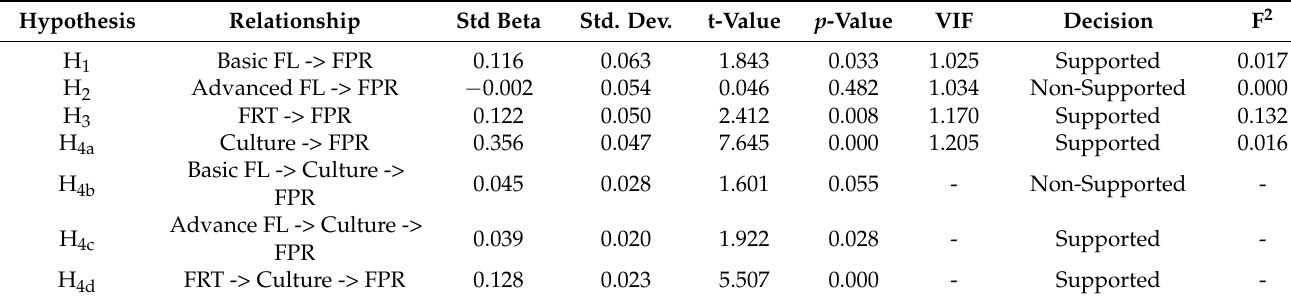
Table 6. Evaluation of Structural Model.